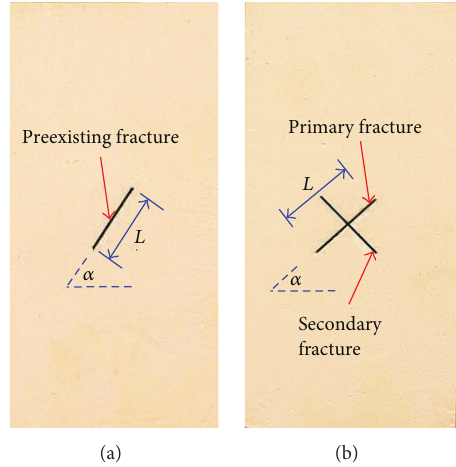
Figure 2: Specimens with different preexisting fracture geometries. (a) Single fracture specimen. (b) X-shape cross fractures